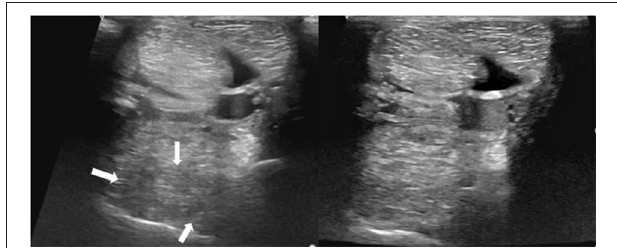
FIGURE 9 | Transverse images of a proximal suspensory ligament about 5cm distal the head of the MTII. Left is before the treatment and right ∼ 6 months after the treatment with BMAC. The lesion is distinguished by three hypoechogenic areas (white arrows), loss of the dorsal margins and enlargement of the ligament. Despite the obvious increase of the echogenicity and reduction of the size of the proximal suspensory ligament, this horse never became sound.